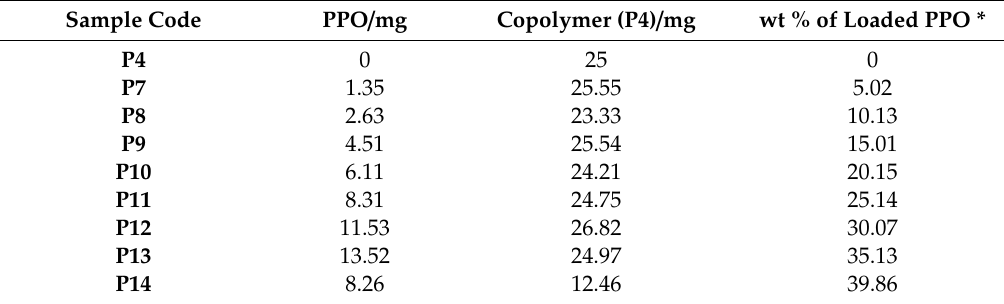
Table 3. Description of the weight fraction of the loaded polymers P7–P14.